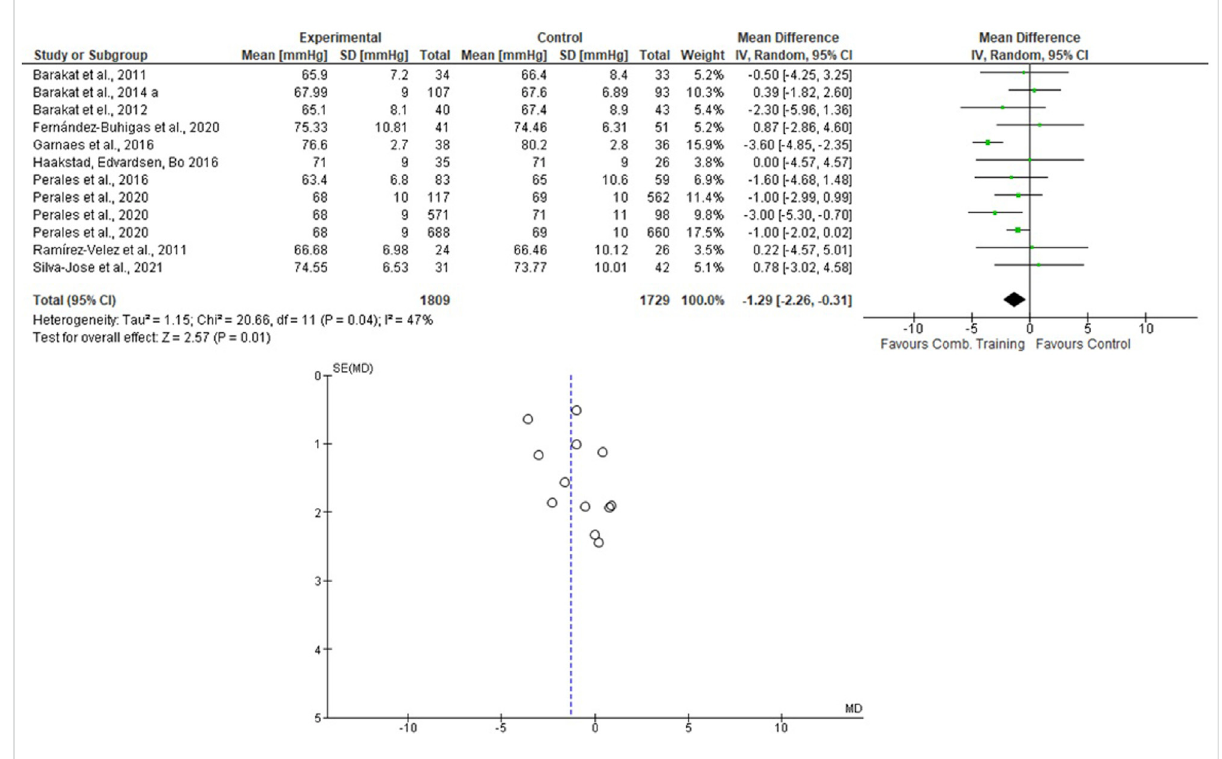
FIGURE 7 Effects of the AT + ST on DBP in pregnant women and funnel plot for detecting bias and